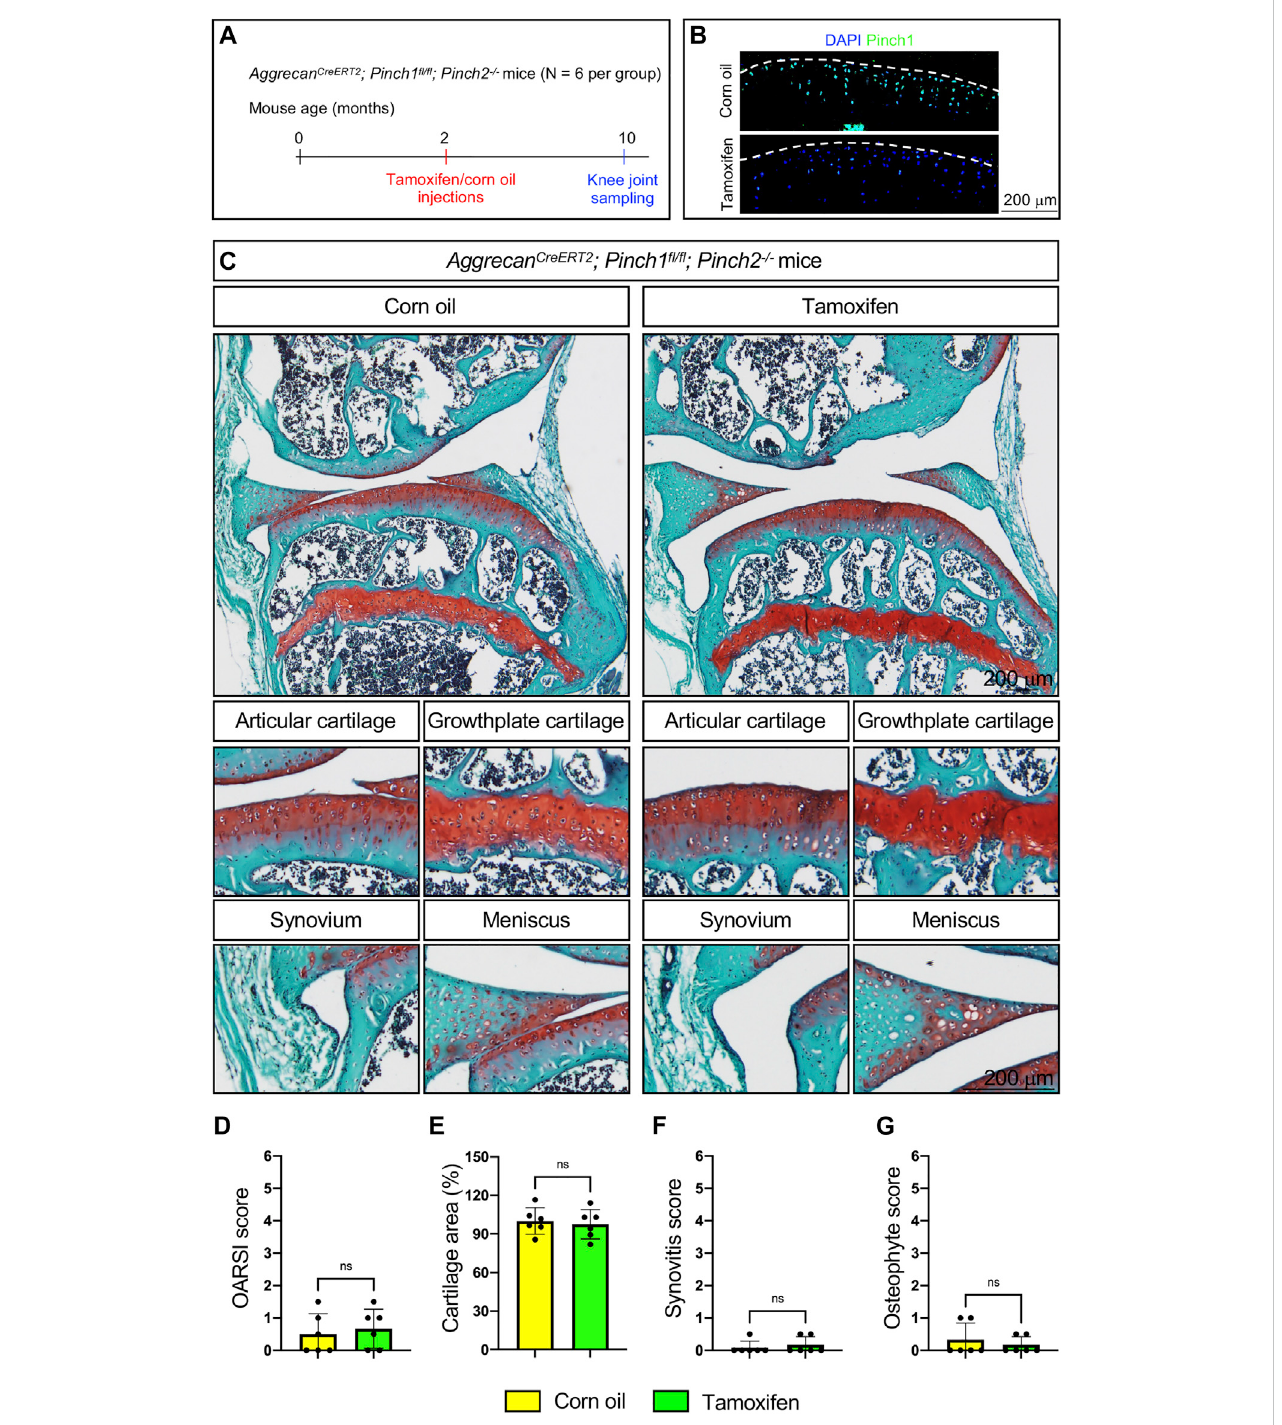
FIGURE 2 Pinch1/2 loss does not induce marked abnormalities in knee joints in adult mice. (A) A schema illustrating the experimental design. (B) Immuno fl uorescence staining of Pinch1 in articular cartilage. Scale bar: 200 μ m. (C) Representative safranin O and fast green-stained images of knee joint sections from tamoxifen- or corn oil-treated Aggrecan CreERT2 ; Pinch1 fl ox/ fl ox ; Pinch2 − / − mice at 10 months of age. Higher magni fi cation images in lower panels areshowingtheareasofarticularcartilage,growth-platecartilage,synovium,andmeniscus.Scalebar:200 μ m. (D – G) Quantitativehistological analyses ofOARSI(osteoarthritisresearchsocietyinternational)score,cartilageareas,synovitisscore,andosteophytescoreusingkneejointsections.Note:N=6mice for each group. Results are expressed as mean ± standard deviation (s.d.). ns: not signi fi cant.